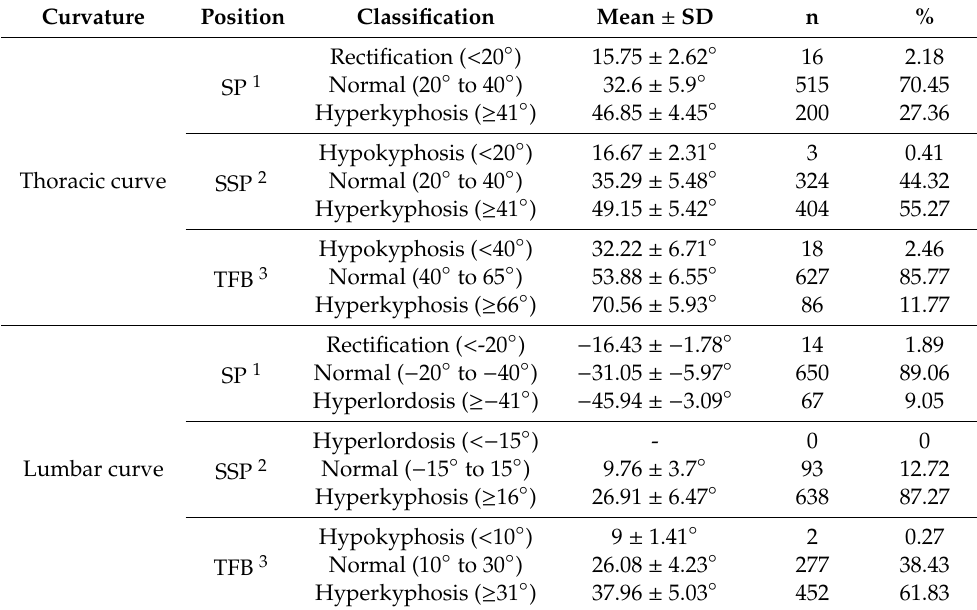
Table 4. Mean (SD), absolute and relative frequency of children in each classification by assessment position for each spinal curve according to normality